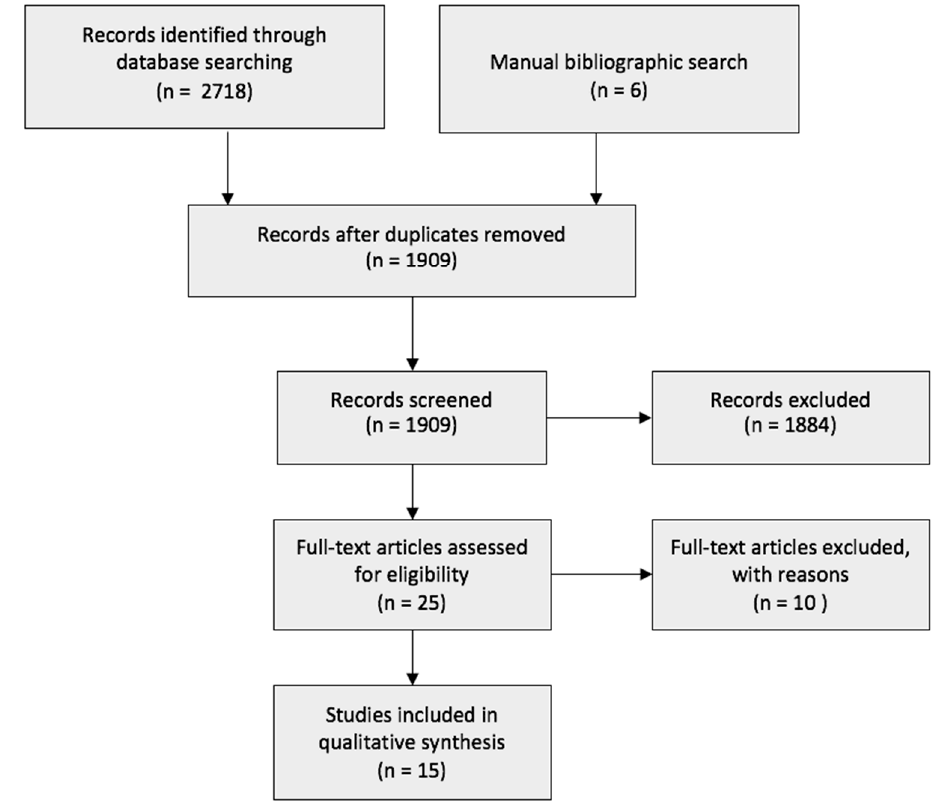
Figure 1. Flowchart of the search strategy.